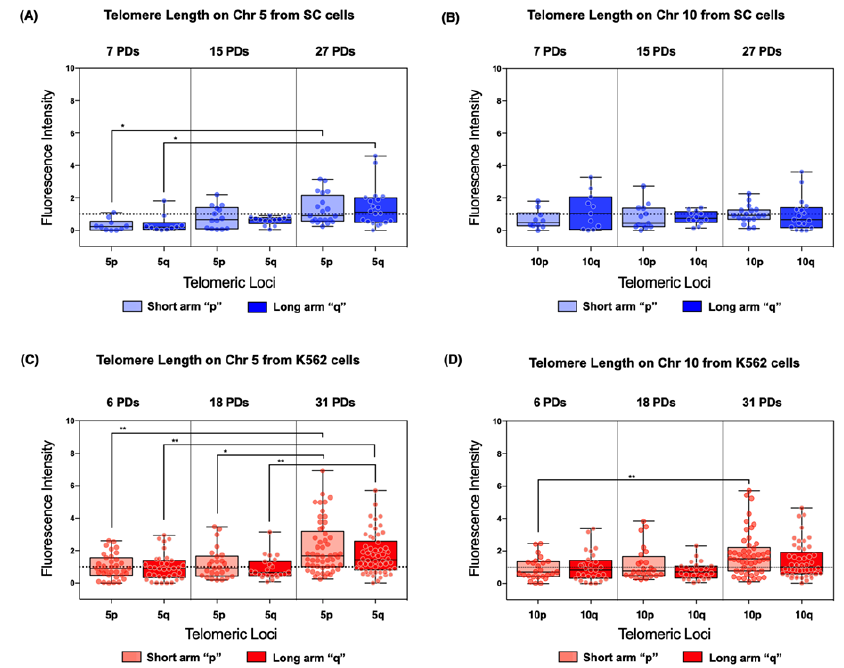
Figure 7. Individual chromosome arms displayed different lengthening patterns. Telomere length was evaluated on chromosomes 5 and 10. ( A , C ) In both cell lines, the telomeres from chromosome 5 were significantly extended after 27 PDs in SC cells and after 31 PDs in K562 cells. ( B ) No discernible lengthening occurred in chromosome 10 of the SC cells. ( D ) A lengthening pattern was evident in chromosome 10 of the K562 cells, but the change was only significant at locus 10p. ( A – D ) The fluorescence intensity of the telomeric probe was normalized against a centromeric probe and expressed in arbitrary units (AU). Data were analyzed with a Kruskal–Wallis test and Dunn’s multiple comparisons test. Adjusted p value < 0.05 (*), < 0.005 (**).